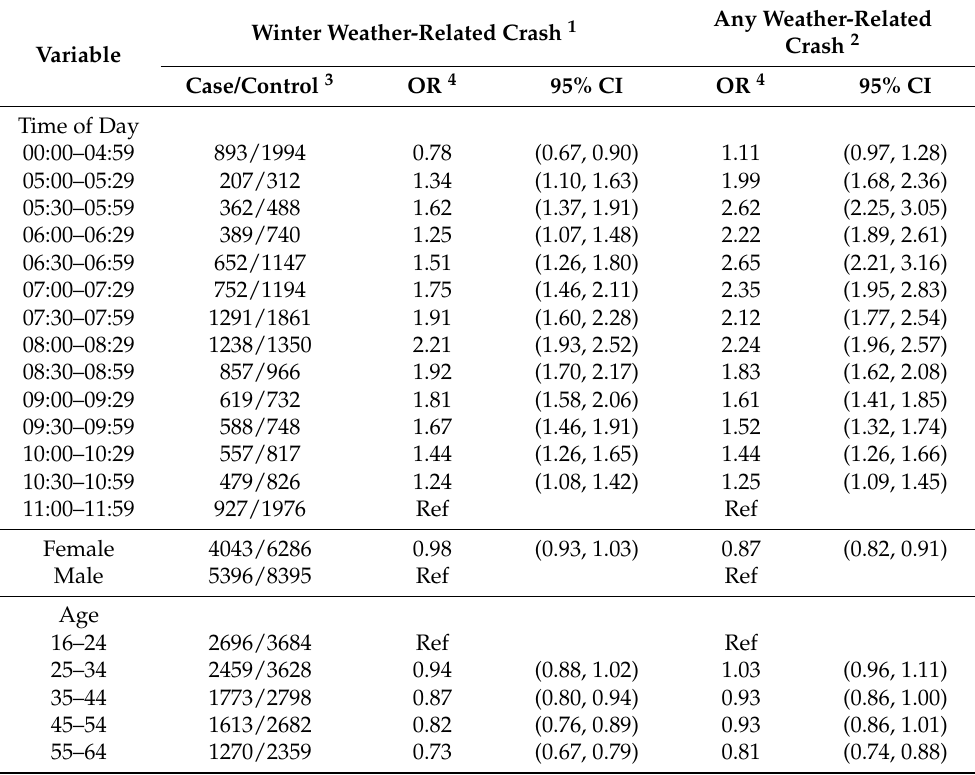
Table 2. Odds Ratios for time period having a winter weather-related and any weather-related circumstance during the work